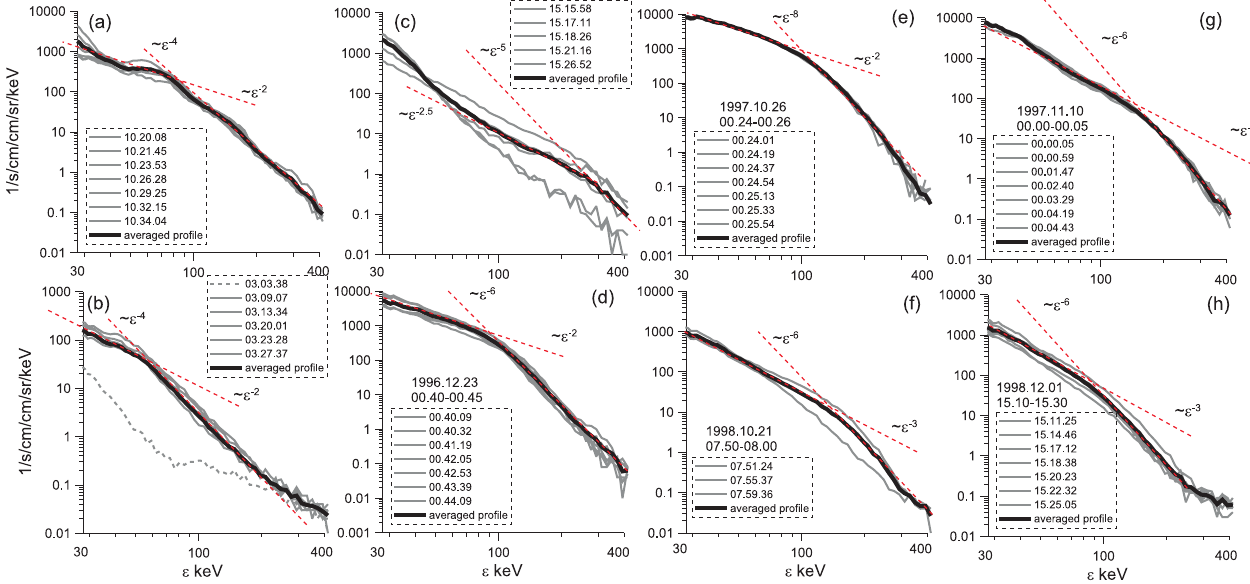
Fig. 9. Spectra of high-energy electrons observed by Interball-tail for three long events 28 November 1995, 10:00–12:00 (a) , 15 Decem- ber 1996, 02:00–04:00 (b) , 16 December 1998, 14:30–16:30 (c) , and for five short events (dates are presented inside panels).